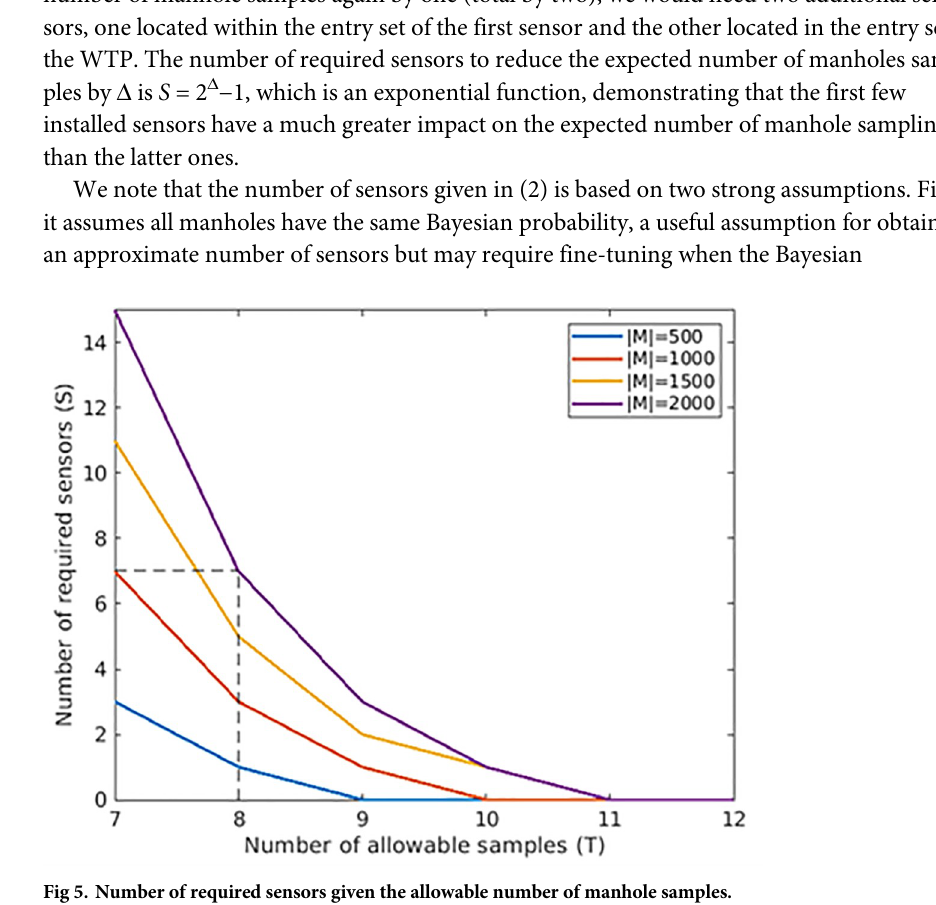
Fig 5. Number of required sensors given the allowable number of manhole